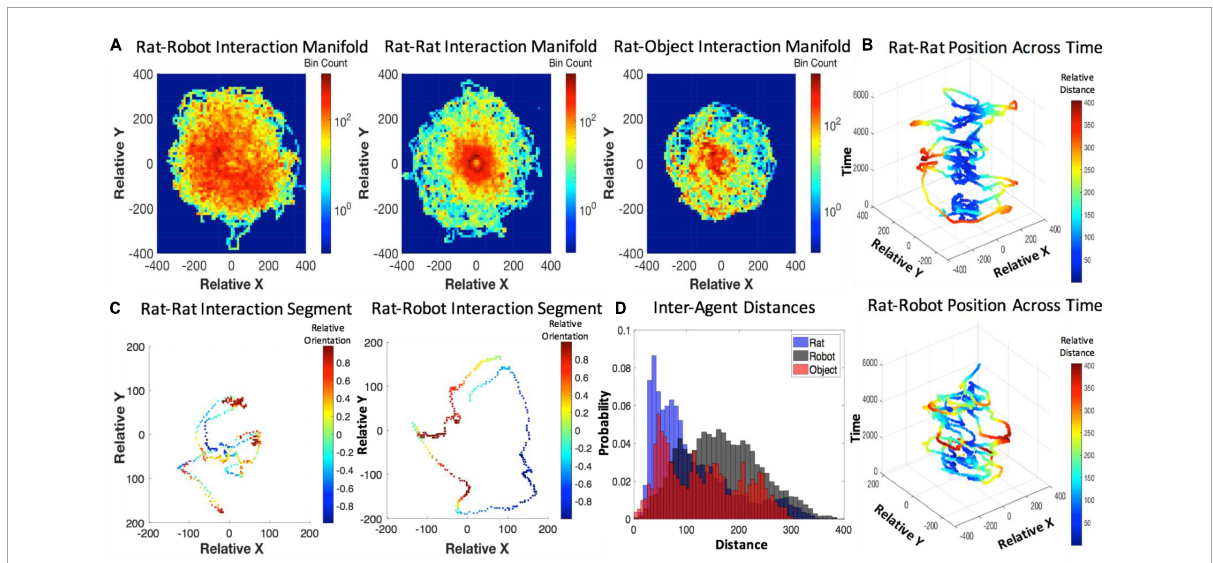
FIGURE5 (A) Agent-based interaction manifolds represented by 2D histogram bins along the relative x - and y - position axes. (B) Relative position over time for the rat–rat and rat–robot interactions with a color map revealing inter-distance between agents (C) , shorter segments of relative position of rat–rat and rat–robot interactions with a color map revealing relative orientation. (D) A histogram of inter-agent distance per rat, robot, and object conditions.